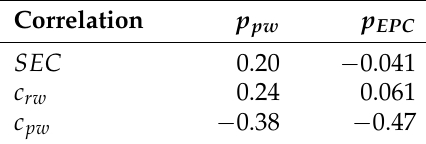
Table A5. Pertinent Pearson’s correlation coefficients ( ρ ) for different municipal-scale desalination factors and economic considerations of cost of product water, p pw , and EPC price, p EPC , reveal little to moderate correlation between factors. Values have been rounded to two significant